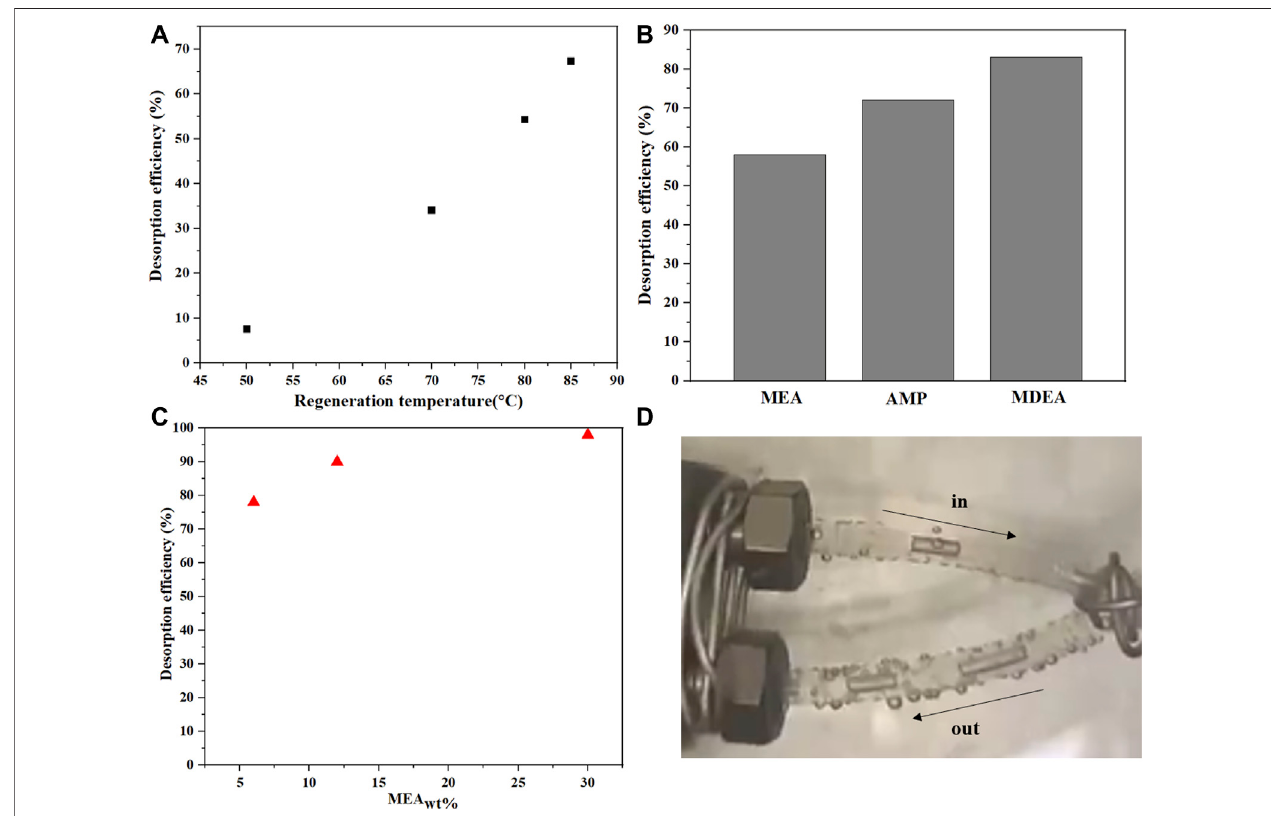
FIGURE8|(A) Effectoftemperatureondesorptionef fi ciencyforMEAataresidencetimeof476 s. (B) Desorptionef fi ciencyofthreeCO 2 -loadedaminesolutionsat regeneration temperaturesof85 ° Cand residence timeof476 s. (C) MEA desorption ef fi ciency at 85 ° Cfor different MEAconcentrations at regeneration temperaturesof 85 ° C. (D) image shows the increase in the bubble size due to desorption 85 °